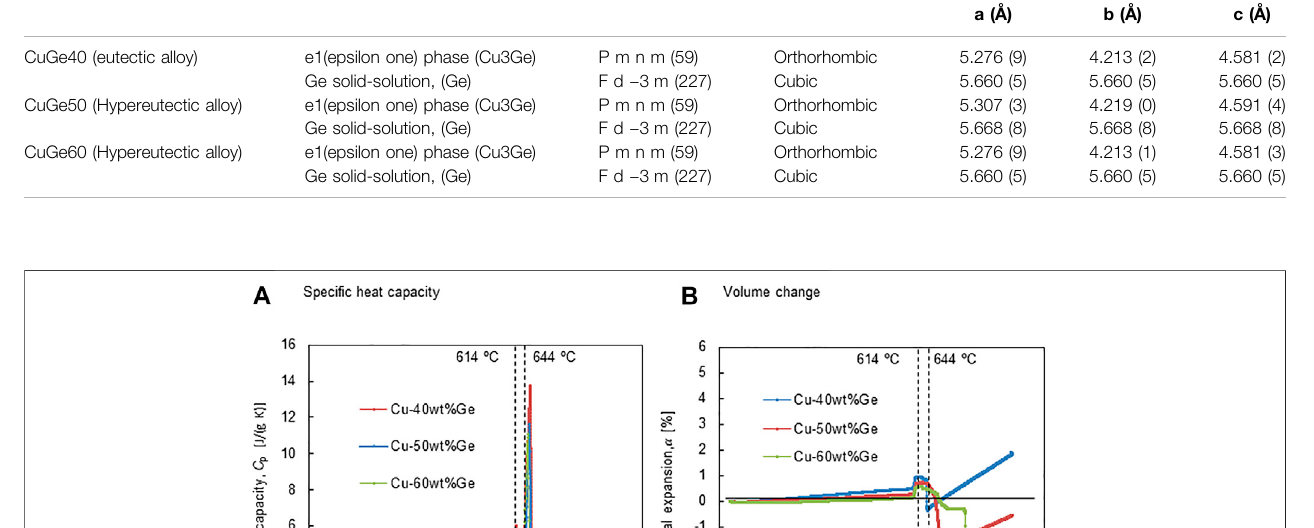
TABLE 1 | Solid phases, space grope, crystal system, and lattice parameters of re fi ned structured of Cu – Ge alloys. Material